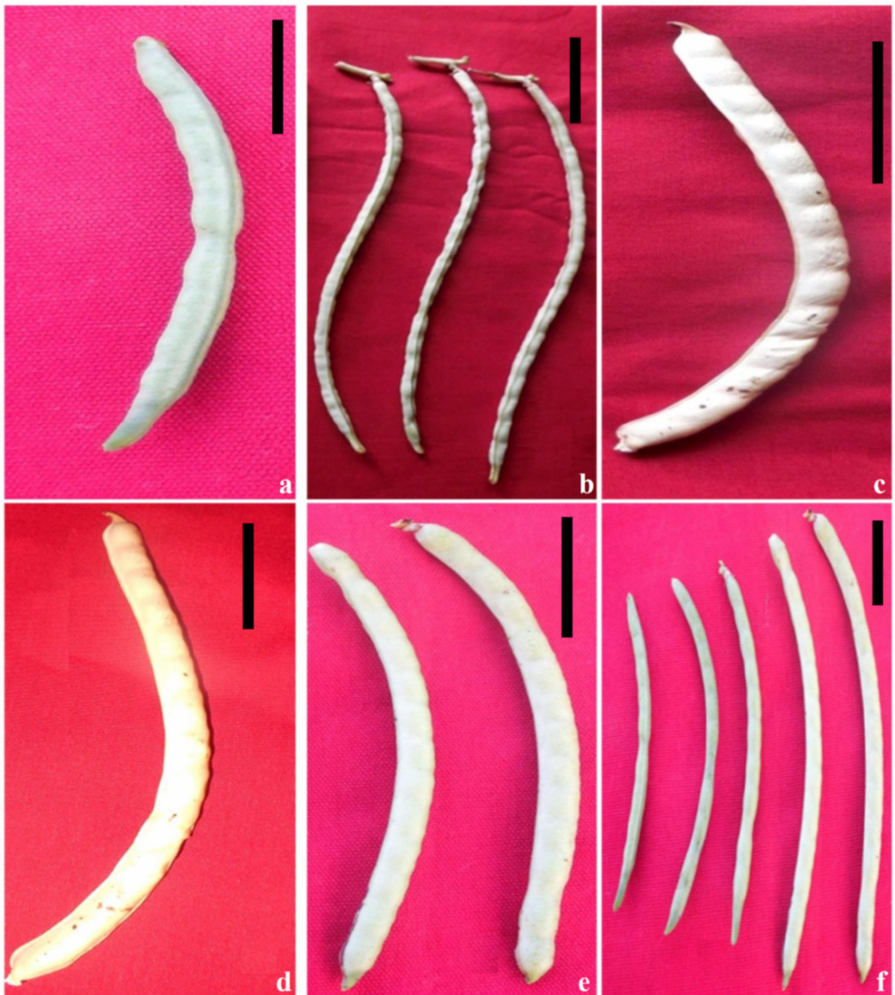
Figure 9. Representative photographs of gamma rays and sodium azide-induced alterations in pod size. ( a ) Control pod, ( b ) narrow pods, ( c ) bold-seeded pods, ( d ) broad pod, ( e ) pod width variations, and ( f ) pod length variations. Scale Bar = 5